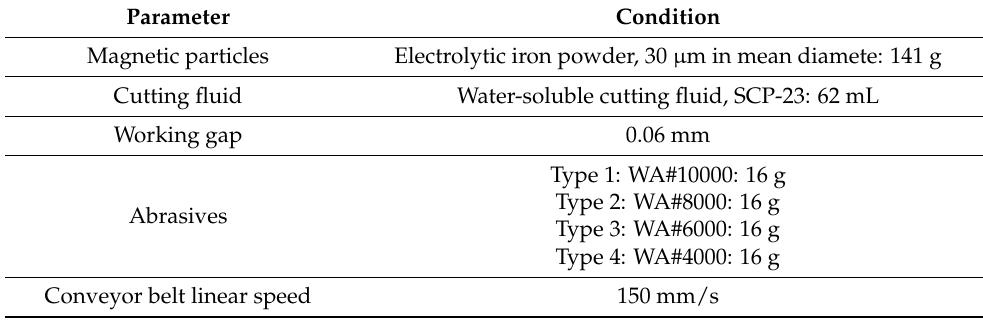
Figure 18. Effects of abrasive particle size on surface roughness. Table 4. Experimental